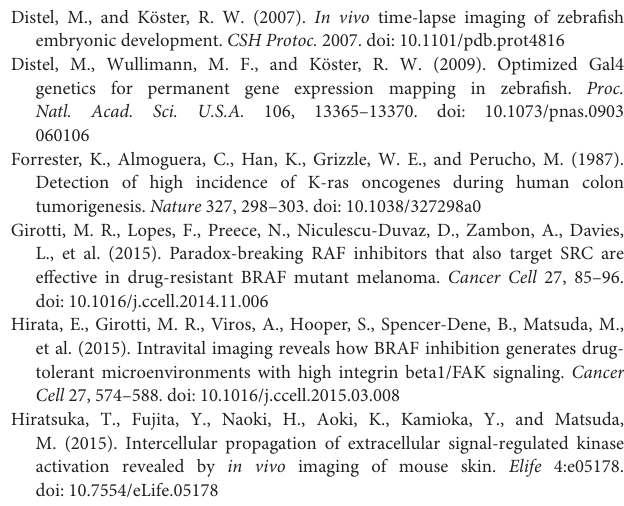
active. Around 25min after compound administration Erk activity is visibly decreased and by 50min cells show Erk signaling inhibition. Z-stack images were recorded approximately every 2min for 1h on a Leica SP8 X WLL confocal microscope using a 40x objective. Z-stacks are shown as maximum